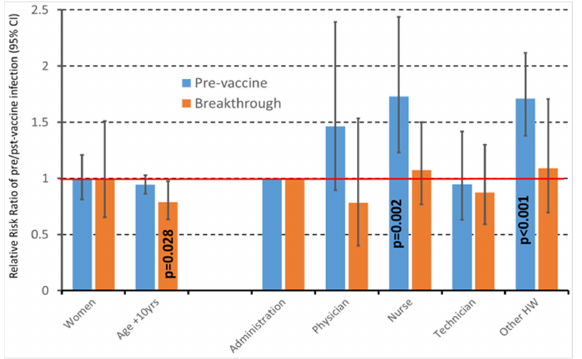
Figure 1. Impact of socio-demographic characteristics on the risk of either pre-vaccine infection (blue columns) or breakthrough infection (orange columns) in the eight centers (31,837 HWs) pro- viding individual data. Columns are Relative Risk Ratios (RRR), and bars are 95% confidence intervals. RRRs were estimated by multinomial logistic regression, adjusting standard errors for intra-center